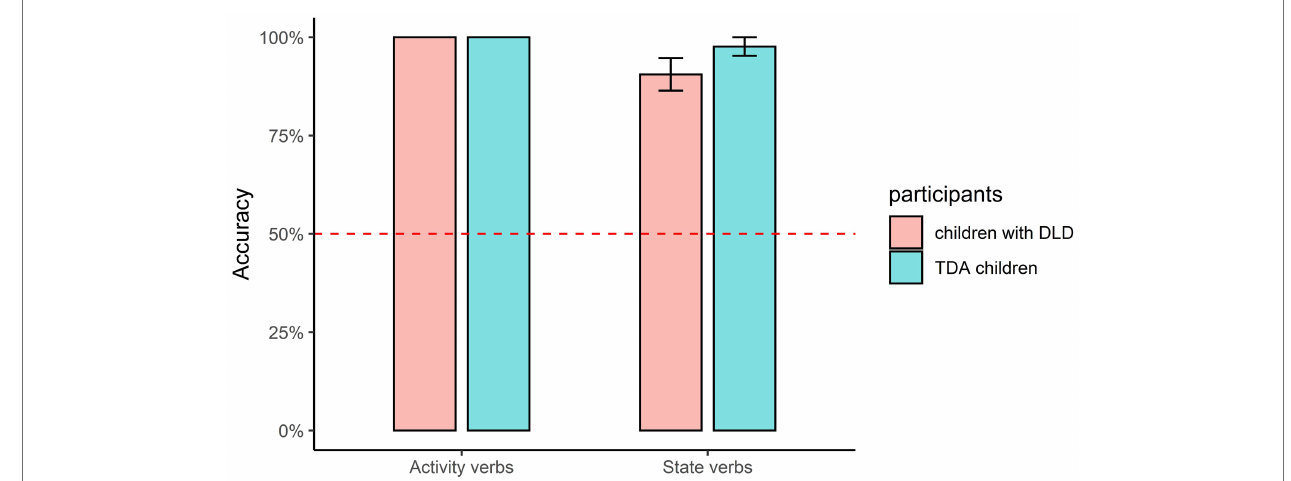
FIGURE 5 | Accuracy of - zhe being combined with different types of verbs.